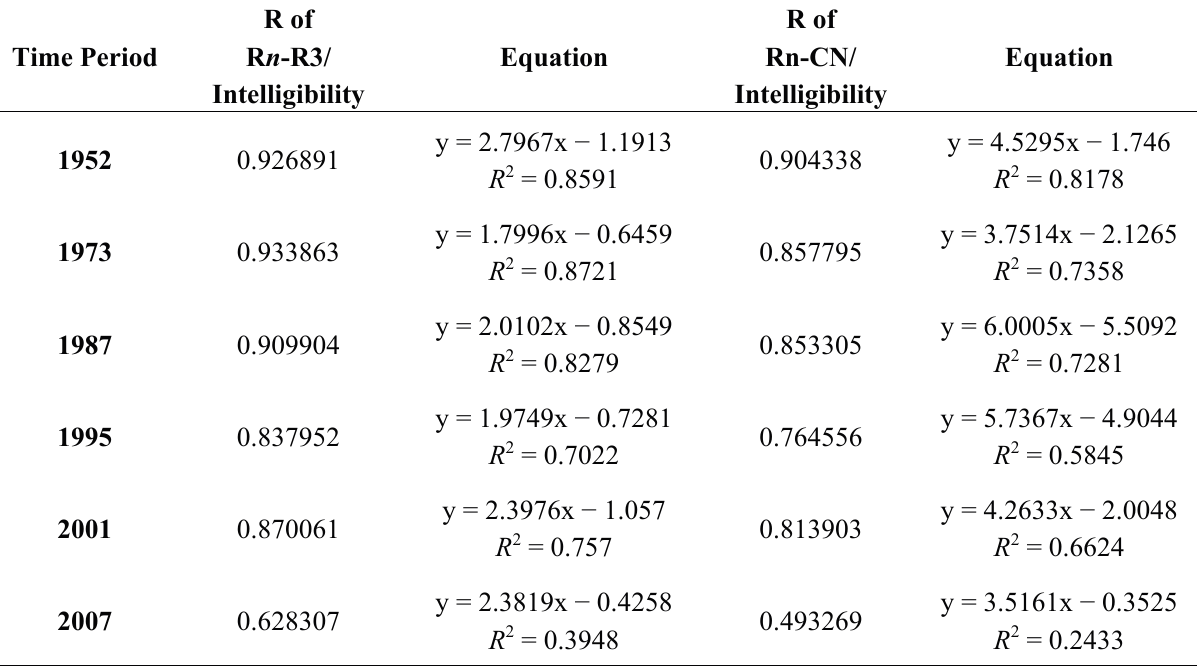
Table 4. Correlation values of global and local measures of ward 72 (where R = correlation, R n = global integration, R3 = local integration, and R 2 = tangent of slope).